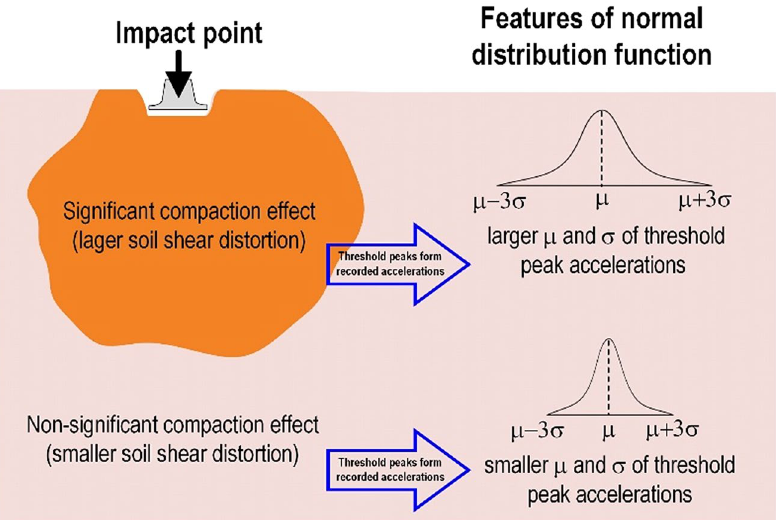
Figure 11. Schematic to illustrate the concept of normal distribution function to represent the threshold peaks features.